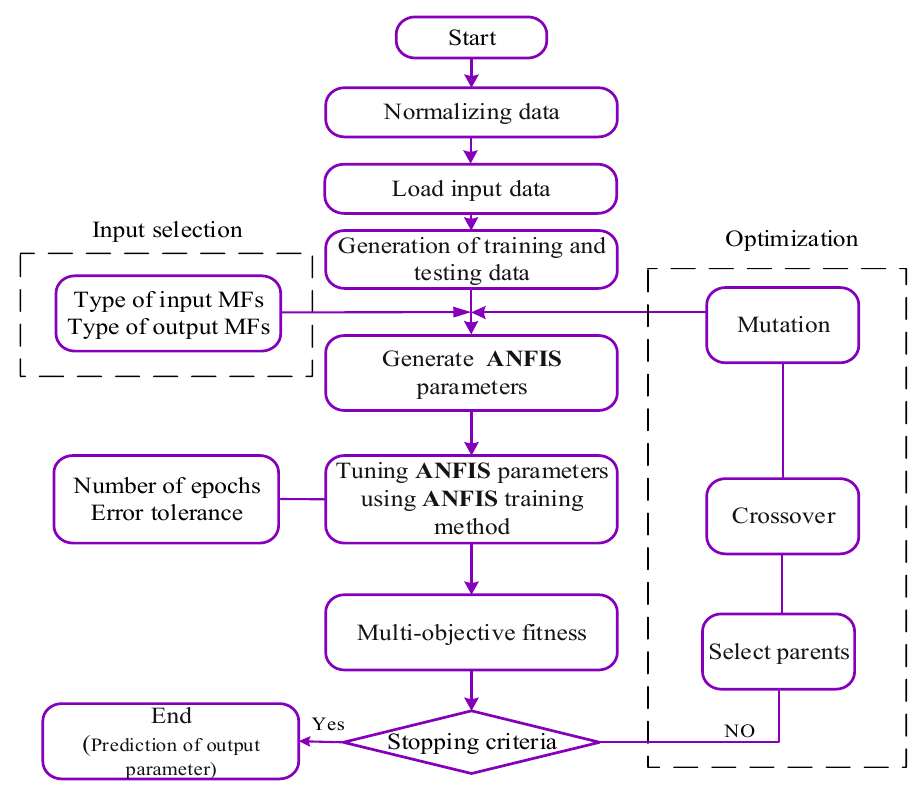
Figure 2. Steps of ANFIS-genetic algorithm (GA) model procedure.